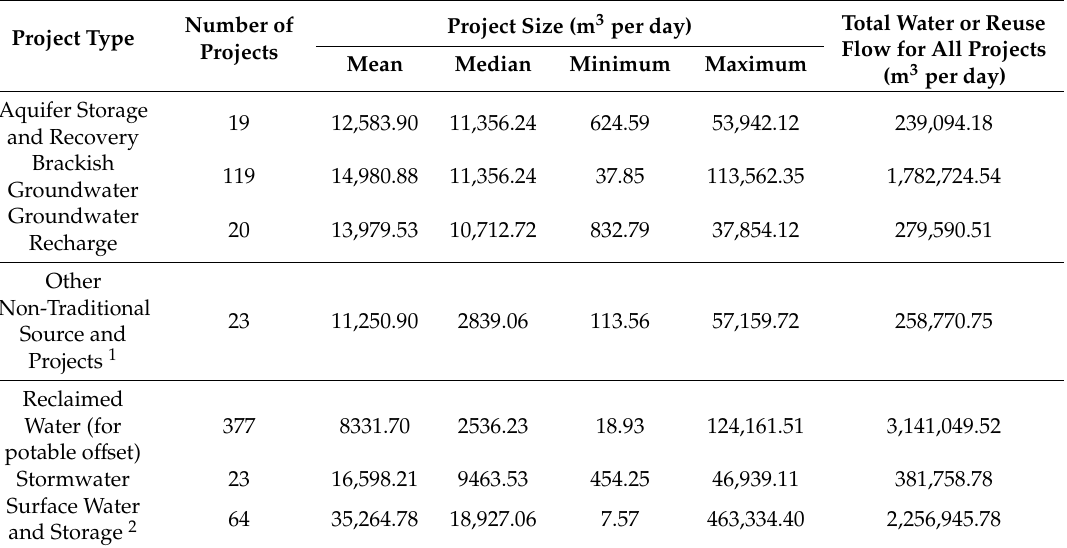
Table 2. Project number, size, and total capacity, by project